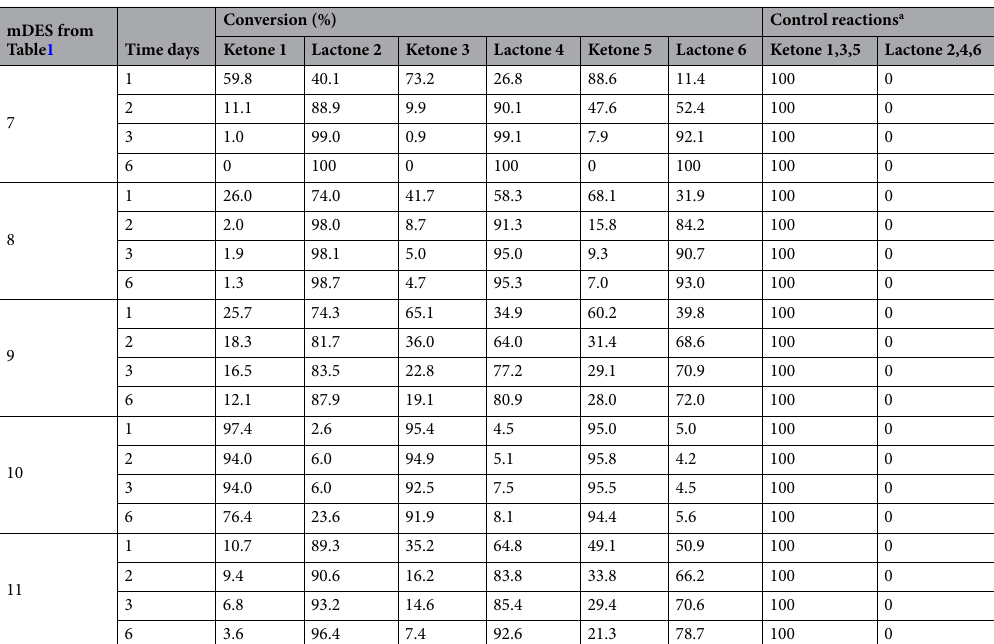
Table 3. The conversion (according to GC) of ketones 1 , 3 and 5 to corresponding lactones in different DES medium. a Control reactions were carried out by excluding respectively lipase, octanoic acid and oxidant from the reaction